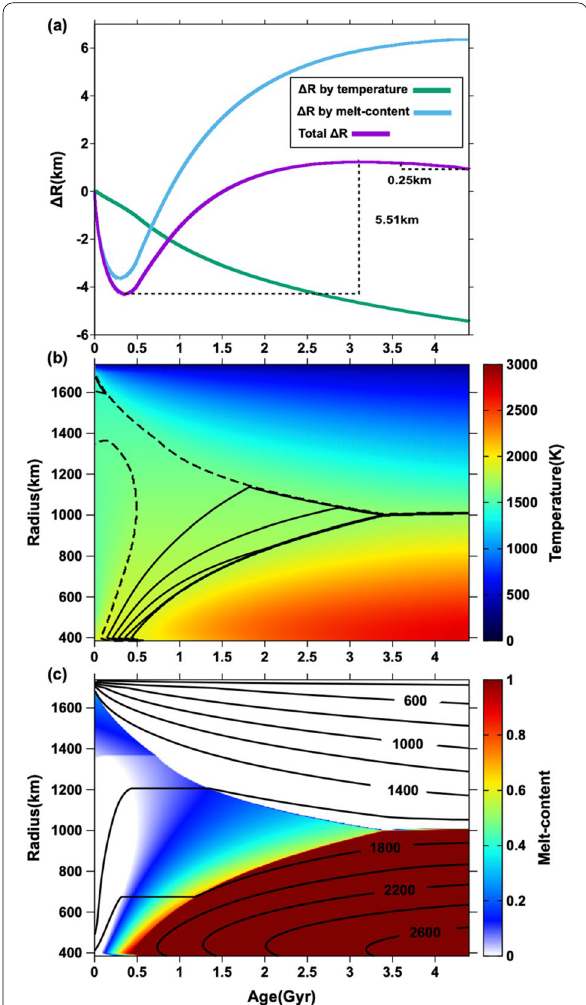
Fig. 3 Model 1. We calculated this model by assuming M ∗ = 0 in the reference model: only the effects of thermal diffusion, internal heating, and melting are considered, and the effects of magma migration are switched off. a – c Are the same as Fig. 2a, c, and e, respectively. In b the contour interval is 0.2 starting from 0 (indicated by the dashed line)